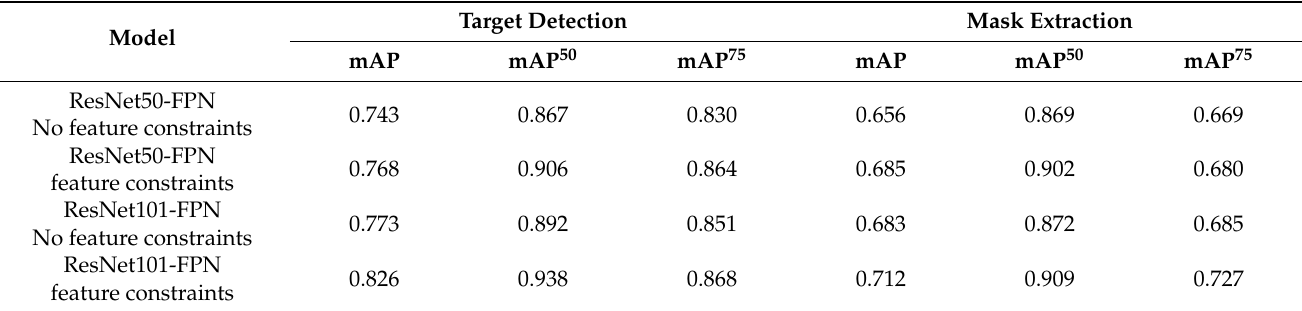
Table 4. Model performance obtained with or without feature constraints.